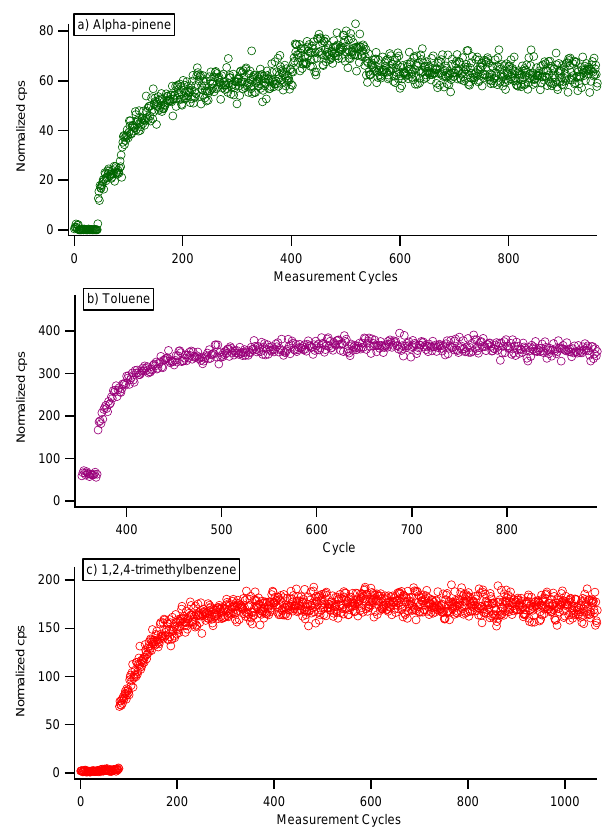
Fig. 2. Three of the gas-phase organic compounds generated with the dynamic dilution system. All mixing ratios at the outlet re- mained stable, (a) alpha-pinene for 2.4 hours (RSD = 8.38%) (b) toluene for 51.8 min (RSD = 3.81%) (c) 1,2,4-trimethylbenzene for 1.56h (RSD =